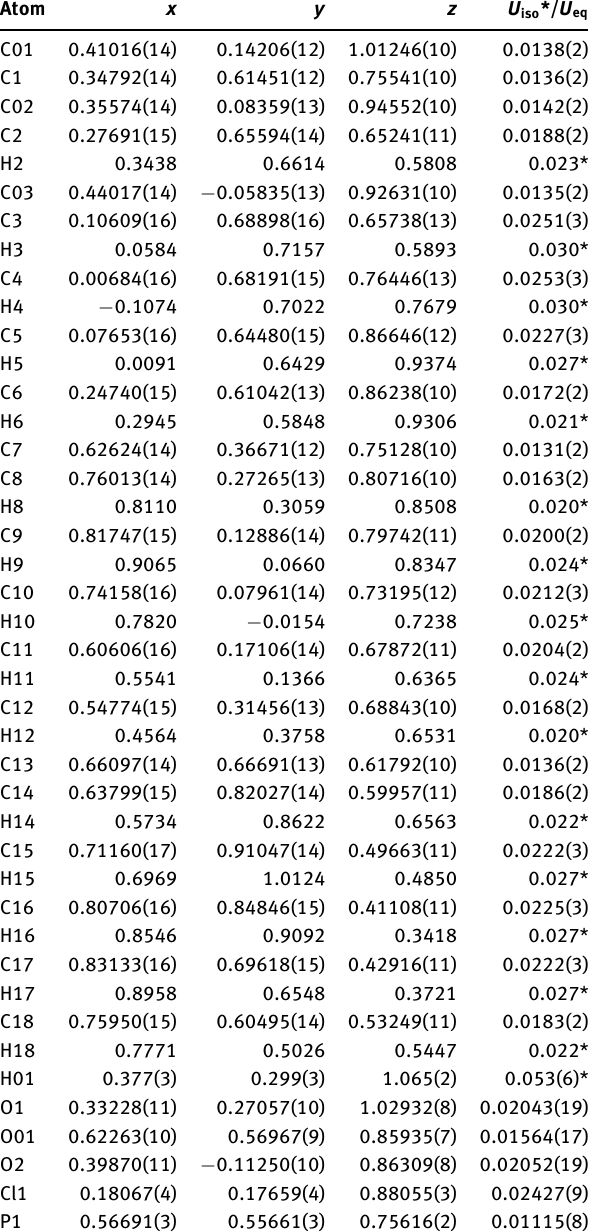
Table 2: Fractional atomic coordinates and isotropic or equivalent isotropic displacement parameters (Å 2